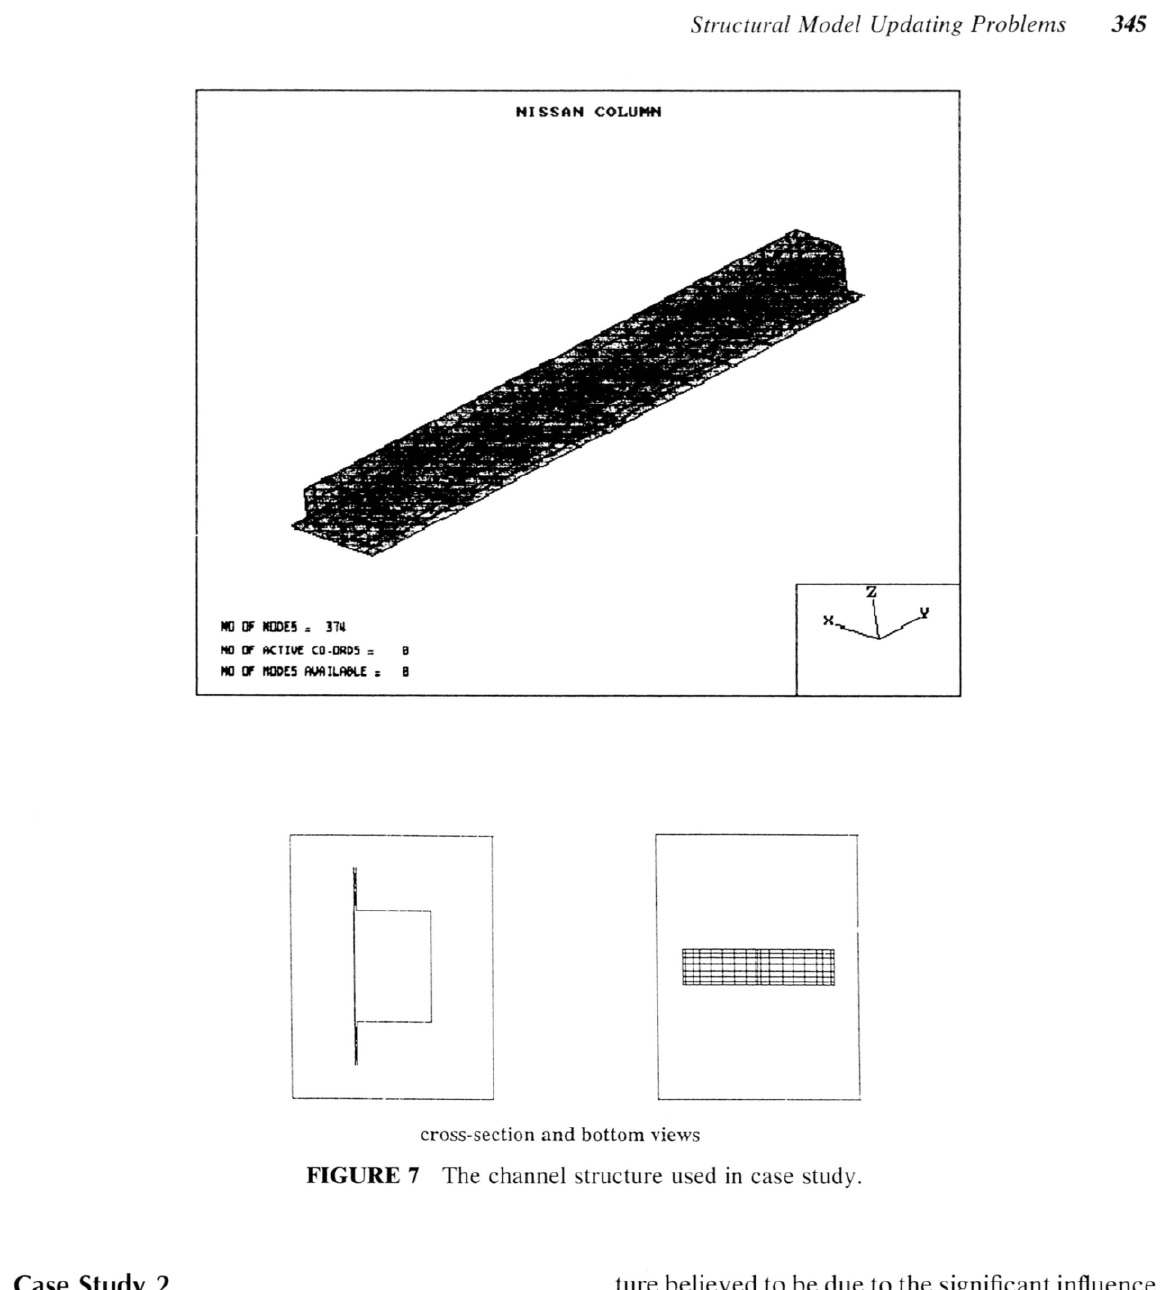
FIGURE 7 The channel structure used in case